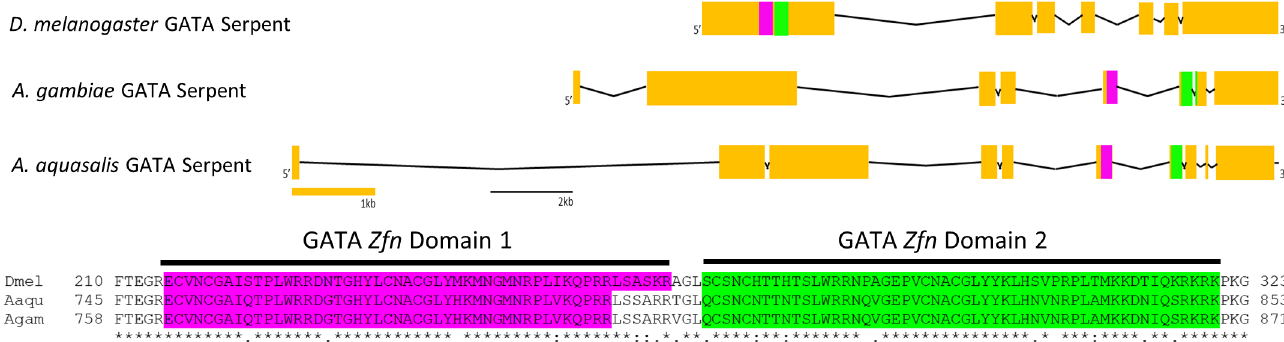
Fig 2. Representation of A . aquasalis GATA Serpent structure. The Fig shows the representation of GATA-Serpent transcripts of D . melanogaster , A . gambiae and A . aquasalis . Yellow boxes represent exons and lines represent introns. Both zinc fingers domains are highlighted in pink (first domain) and green (second domain). The underlined amino acids alignment shows the conservation of the two zinc finger DNA binding